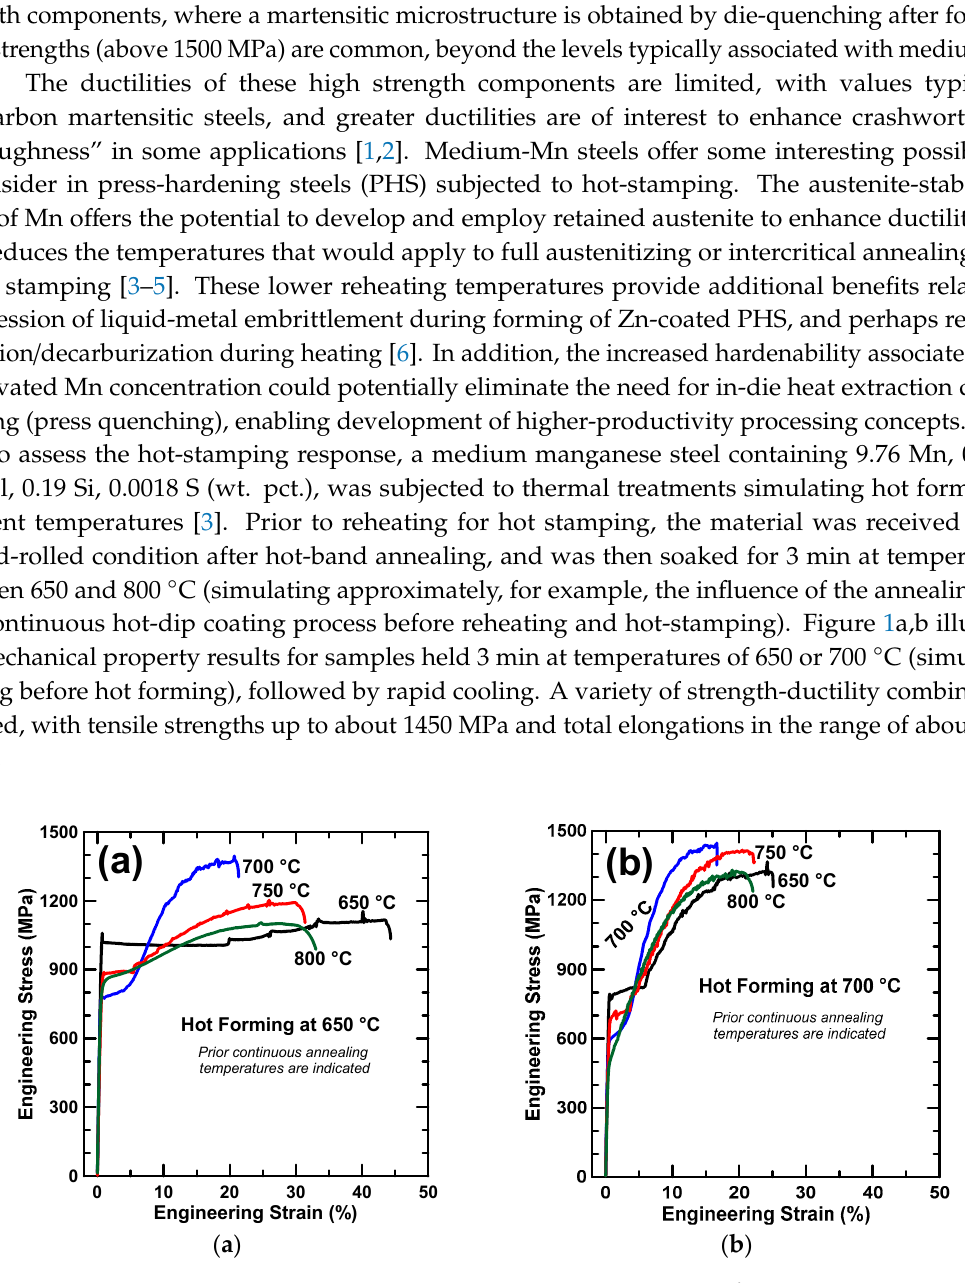
Figure 1. Representative room-temperature engineering stress-strain curves of a 9.76 Mn, 0.16 C, 1.37 Al (wt. pct.) steel subjected to hot-forming thermal simulation (without deformation) using reheating temperatures of ( a ) 650, or ( b ) 700 °C, preceded by continuous annealing at 650–800 °C for 3 min [3].